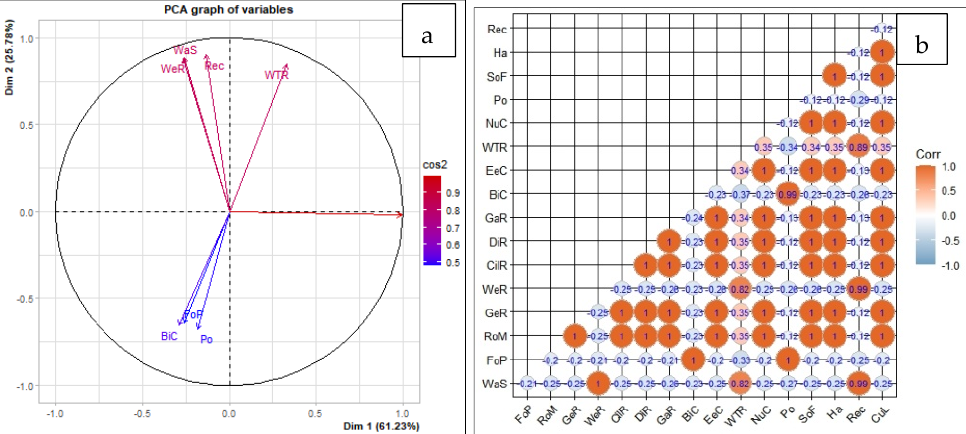
Figure 5. Principal component analysis (PCA) of LULC and different ESs. Note : ( a ) is an ES (variables) factor map that is labeled ES; those are selected shown on the plane; ( b ) is a graph that shows the correlations between ESs. Each ES were denoted as follows: Water supply (WaS); Food production (FoP); Raw materials (RoM); Genetic resources (GeR) Water regulation (WeR); Climate regulation (CilR); Disturbance regulation (DiR); Gas regulation (GaR); Biological control (BiC); Erosion control (EeC); Water treatment (WTR); Nutrient cycling; (NuC); Pollination (Po); Soil formation (SoF); Habitat/refuge (Ha); Recreation (Rec); Cultural (CuL).